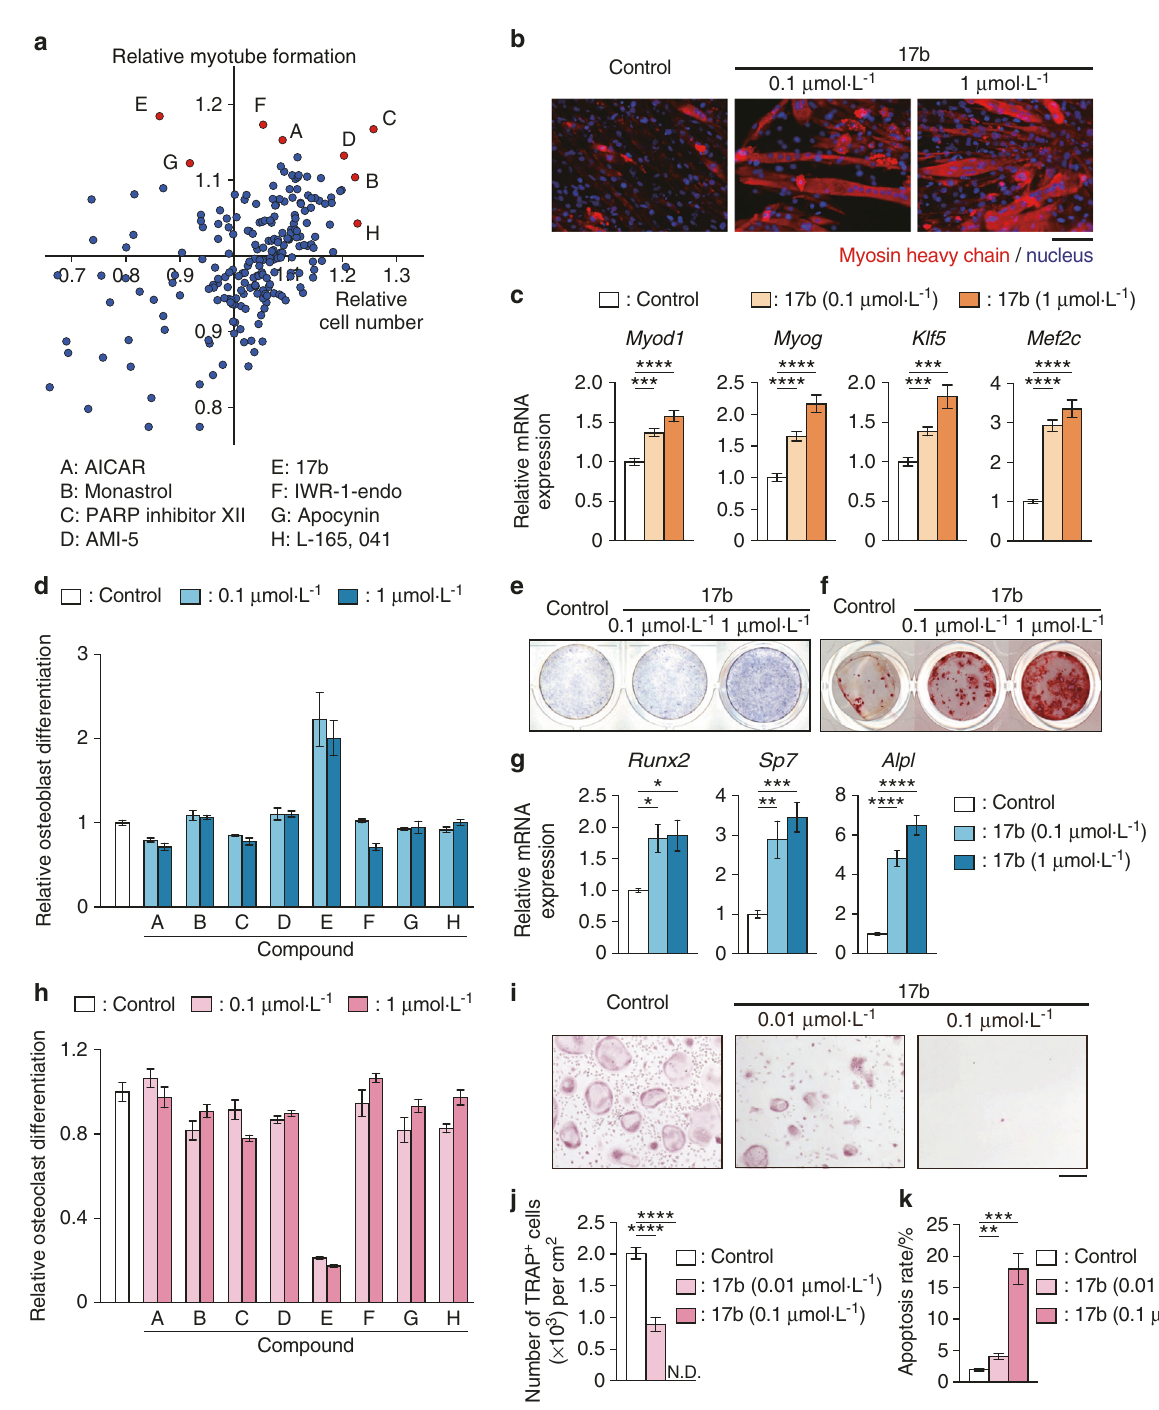
Fig. 1 Sequential screening identi fi ed 17b (locamidazole: LAMZ) as a candidate therapeutic drug for impaired locomotion. a Primary screening for extracting compounds that enhance the proliferation and/or differentiation of myocytes. The relative proliferation and myotube formation are plotted in the scattergram. Each dot represents the corresponding compound. Compounds A – H are as follows: A, AICAR; B, monastrol; C, PARP inhibitor XII; D, AMI-5; E, 17b; F, IWR-1-endo; G, apocynin; and H, L-165,041. The dots depicted in red underwent further screening. b Representative immunocyto fl uorescence images of C2C12 cells. Myosin heavy chain (red); nuclei (blue). c mRNA expression of myogenic genes. d Secondary screening for extracted compounds enhancing osteoblastogenesis based on alkaline phosphatase (ALP) activity. e Representative ALP staining images of osteoblasts. f Representative images of the mineralization of osteoblasts. g mRNA expression of osteoblastic genes. h Tertiary screening for extracting compounds that suppress osteoclastogenesis based on Ctsk expression indicated by LacZ activity. i Representative images of tartrate – resistant acid phosphatase (TRAP) staining. j Number of TRAP + multinucleated cells. N.D. not detected. k Apoptosis ratio of osteoclasts detected by TdT-mediated dUTP nick-end labeling (TUNEL) assay. The data of the effects of 17b were obtained from 3 independent experiments with replicates of three wells. Scale bar, 100 μ m. Statistical analyses were carried out using one-way ANOVA followed by Dunnett ’ s multiple-comparison test or Brown – Forsythe ANOVA test and Dunnett ’ s T3 test. The error bars show the mean ± s.e.m. * P < 0.05; ** P < 0.01; *** P < 0.001; **** P < 0.000